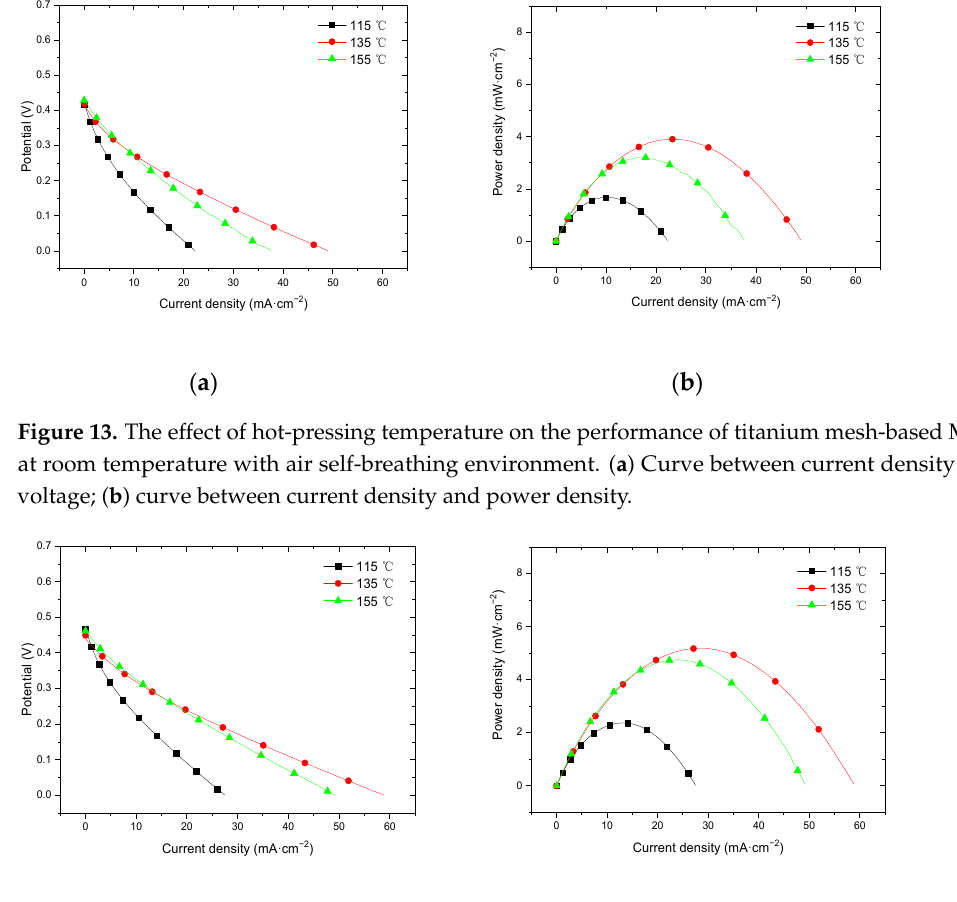
15 of 26 Figure 12. The effect of hot-pressing pressure on the performance of titanium mesh-based MEA at 60 °C with an oxygen environment. ( a ) Curve between current density and voltage; ( b ) curve be- tween current density and power density. 3.3. Effect of Hot-Pressing Temperature on the Performance of Titanium Mesh-Based MEA Under the conditions of the hot-pressing time of 180 s and hot-pressing pressure of 5 MPa, the effects of three hot-pressing temperature conditions of 115 °C, 135 °C, and 155 °C on the performance of MEA are studied. The result is given as follows. 3.3.1. Performance at Room Temperature with Air Self-Breathing Environment Figure 13 shows the curve of the effect of hot-pressing temperature on the perfor- mance of titanium mesh-based MEA at room temperature (25 °C) and atmospheric pres- sure with air self-breathing as the cathode oxidant and a 1 mol·L − 1 methanol + 0.5 mol·L − 1